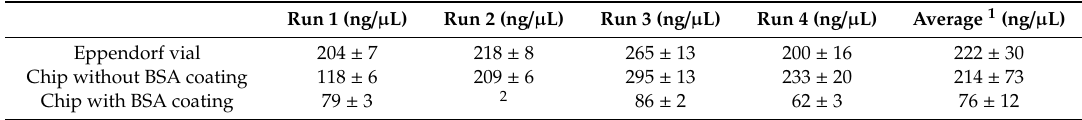
Table 2. The concentration of double-stranded DNA (dsDNA) obtained after 2 h of amplification with the Eppendorf vials and chips with and without bovine serum albumin (BSA) coating (n = 3).